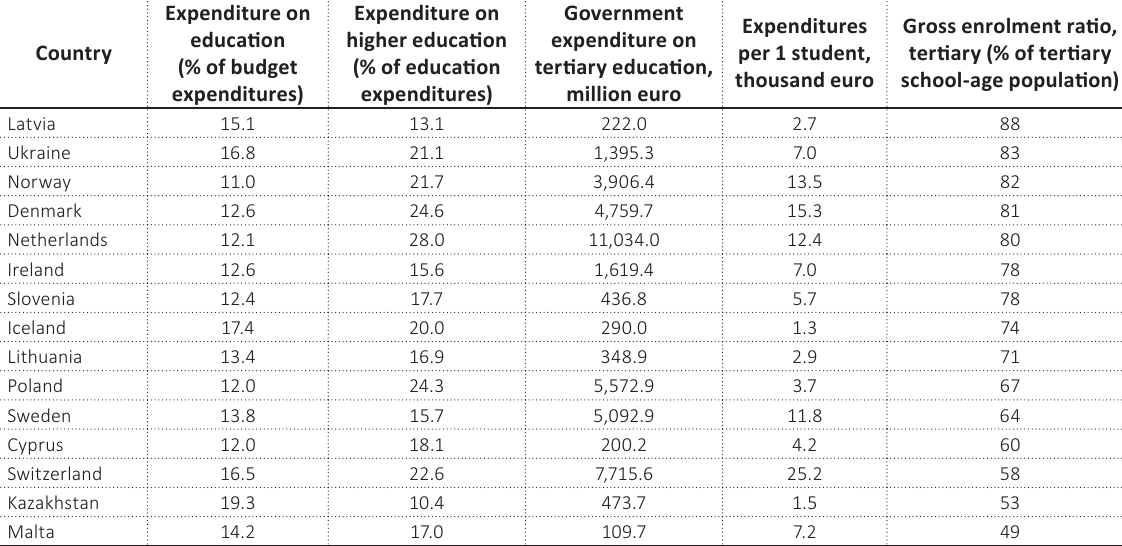
Table 2. Gross enrolment ratio, tertiary (% of tertiary school-age population) in European countries and Ukraine in